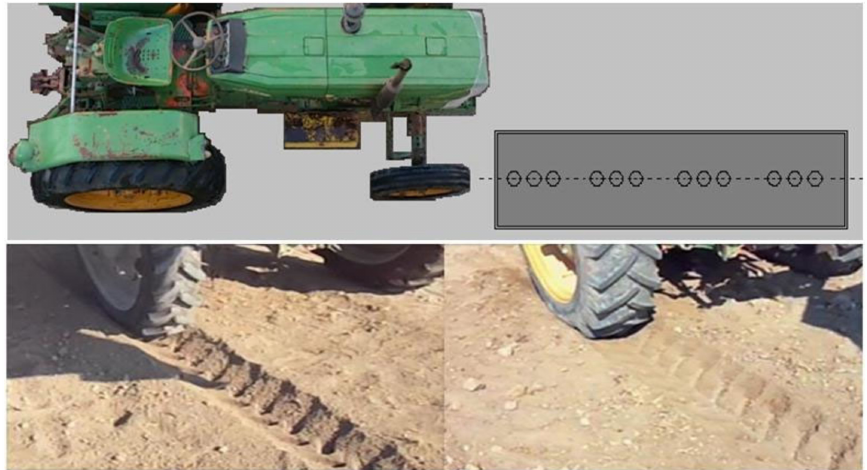
Figure 2. Passing the tractor with two types of tires on the field.